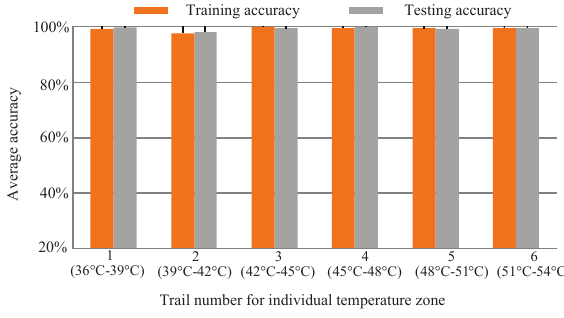
Figure 15. IRT images under normal condition of gearbox in six temperature ranges: ( a ) 36 ◦ C–39 ◦ C ( b ) 39 ◦ C–42 ◦ C ( c ) 42 ◦ C–45 ◦ C ( d ) 45 ◦ C–48 ◦ C ( e ) 48 ◦ C–51 ◦ C ( f ) 51 ◦ C–54 ◦ C.